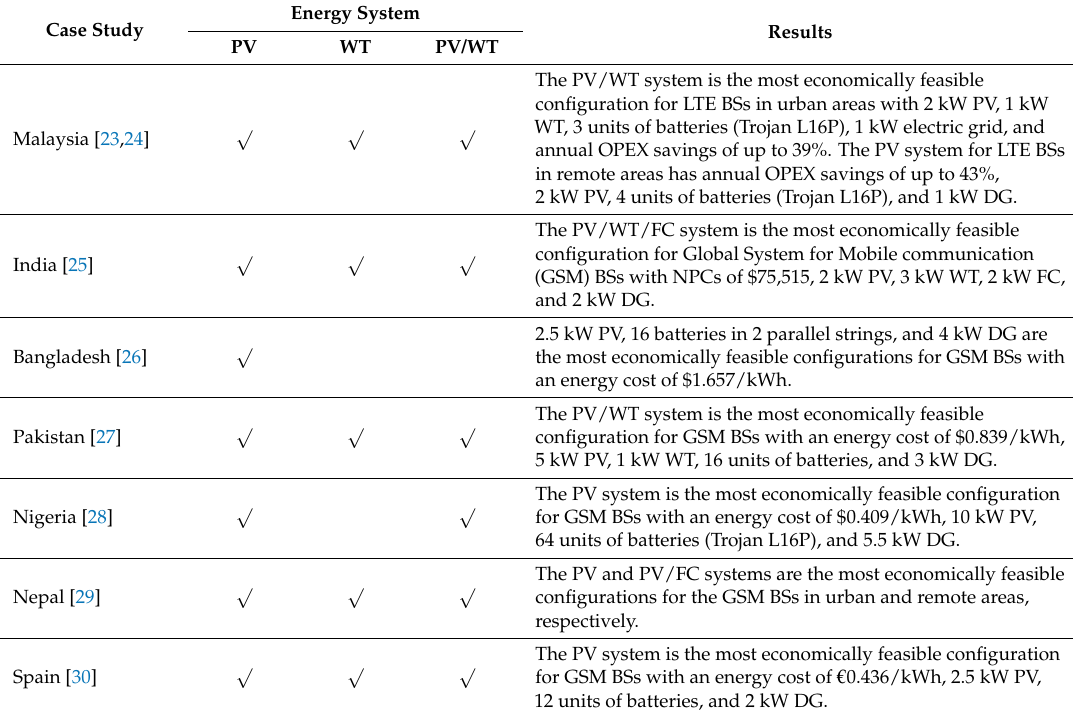
Table 1. Similar projects performed in different